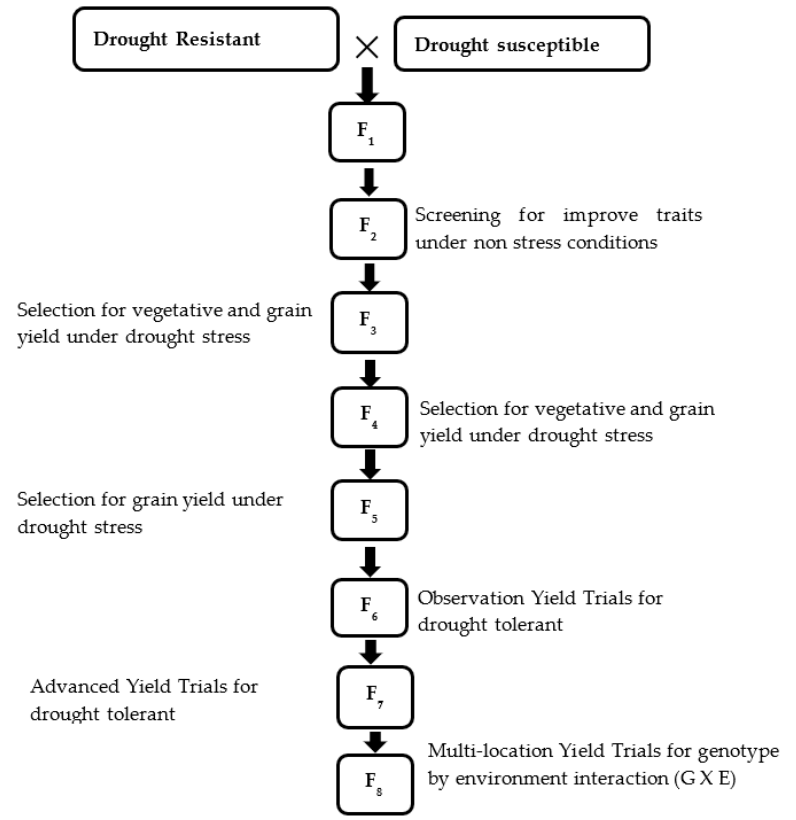
Figure 3. Modified method for conventional yield trail in rice.